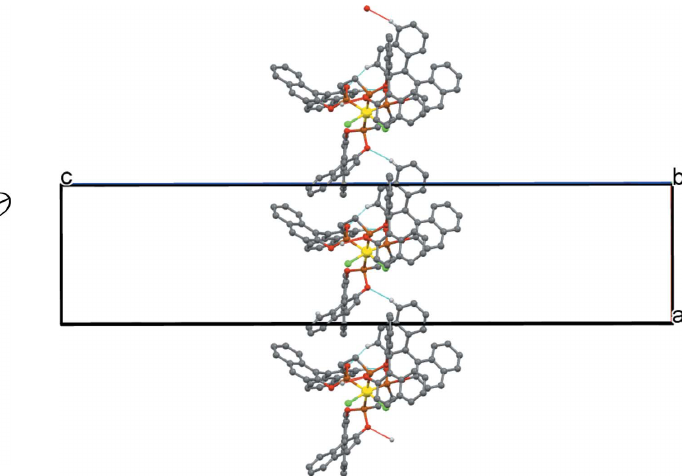
Figure 2 Part of the crystal structure of the title compound showing the formation of [100] chains linked by weak C—H (cid:2)(cid:2)(cid:2) O hydrogen bonds shown as blue lines. The disordered dichloromethane solvent molecules are not shown.